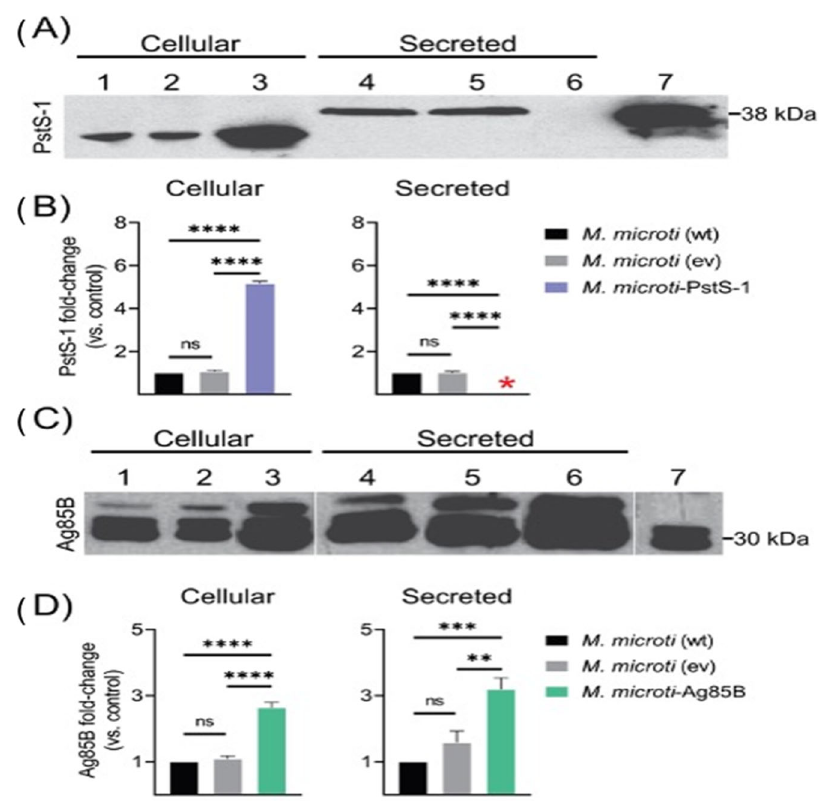
Figure 3. Protein analysis of PstS-1 and Ag85B, either cellular or secreted, produced by M. microti strains. ( A , C ) detection by Western blot of antigens PstS-1 and Ag85B, respectively. ( B , D ) fold expression analysis of PstS-1 and Ag85B, respectively. ( A , C ) lanes 1 and 4: M. microti wild type (wt), lanes 2 and 5: M. microti with empty vector (ev), lane 7 purified protein control. ( A ) lanes 3 and 5 M. microti -PstS-1; ( B ) lanes 3 and 5 M. microti -Ag85B. The fold change analysis performed by densitometric analysis by Image J. Red asterisk indicates the absence of protein. The differences were considered statistically significant with a p ≤ 0.05. **, ***, ****, ns = not significant. Using a one-way analysis of variance (ANOVA) with Tukey’s correction.